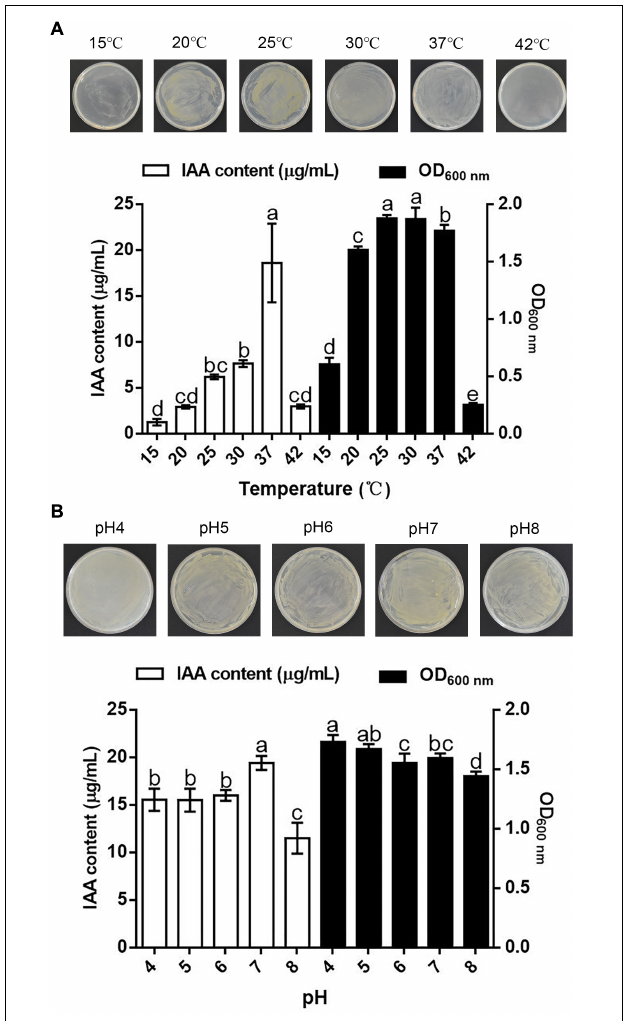
FIGURE 2 | Effect of temperature and pH on the synthesis of IAA by B. pyrrocinia JK-SH007. (A) Effect of temperature on the synthesis of IAA by B. pyrrocinia JK-SH007. (B) Effect of pH on the synthesis of IAA by B. pyrrocinia JK-SH007. The error bars represent the SDs, and different letters indicate significant